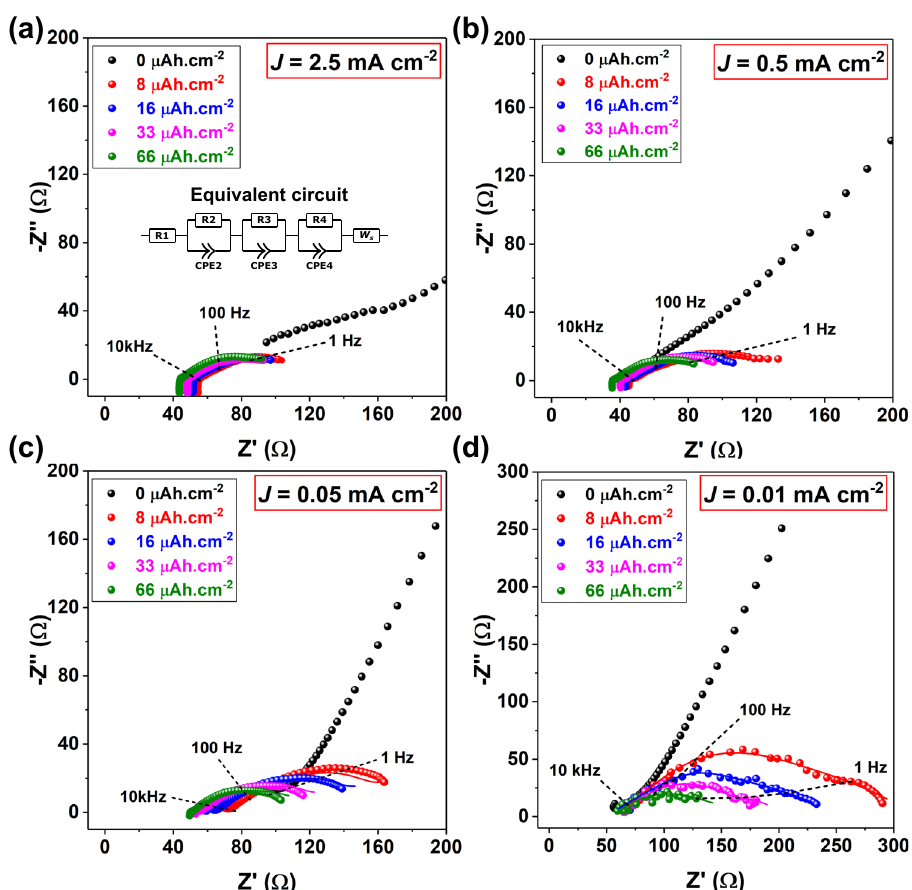
Fig. 3 | EIS measurements in lithium-free anode cell at current densities 0.01 – 2.5 mAcm − 2 . Nyquist curves (raw data as symbols, curve fi ts as lines) depicting evolution of electrochemical impedances for the lithium-free half cell SS ∣ LPSCl ∣ LiIn for plating at a J 2.5 =2.5mAcm − 2 , b J 0.5 =0.5mAcm − 2 , c J 0.05 =0.05mAcm − 2 and d J 0.01 =0.01mAcm − 2 , after passing similar